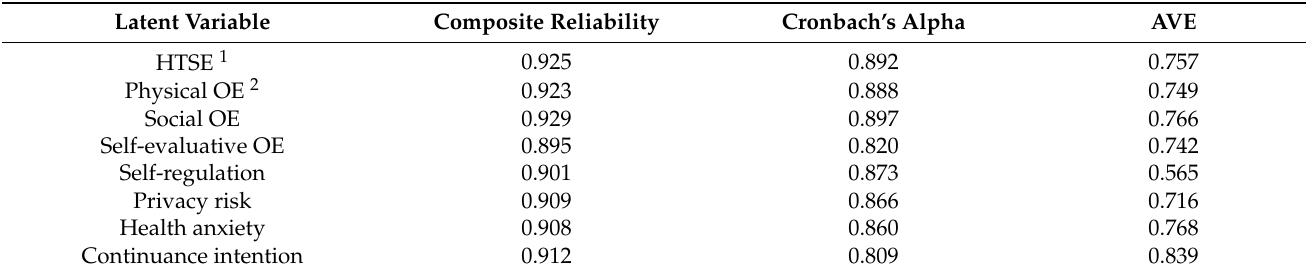
Table 2. Reliability and convergent validity test results.